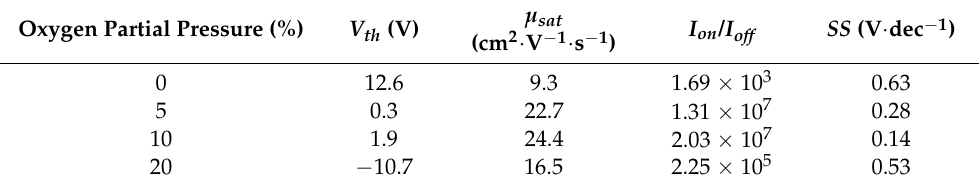
Figure 9. Transfer curves of PrIZO TFTs with different oxygen partial pressures. Table 2. Electric parameters of PrIZO